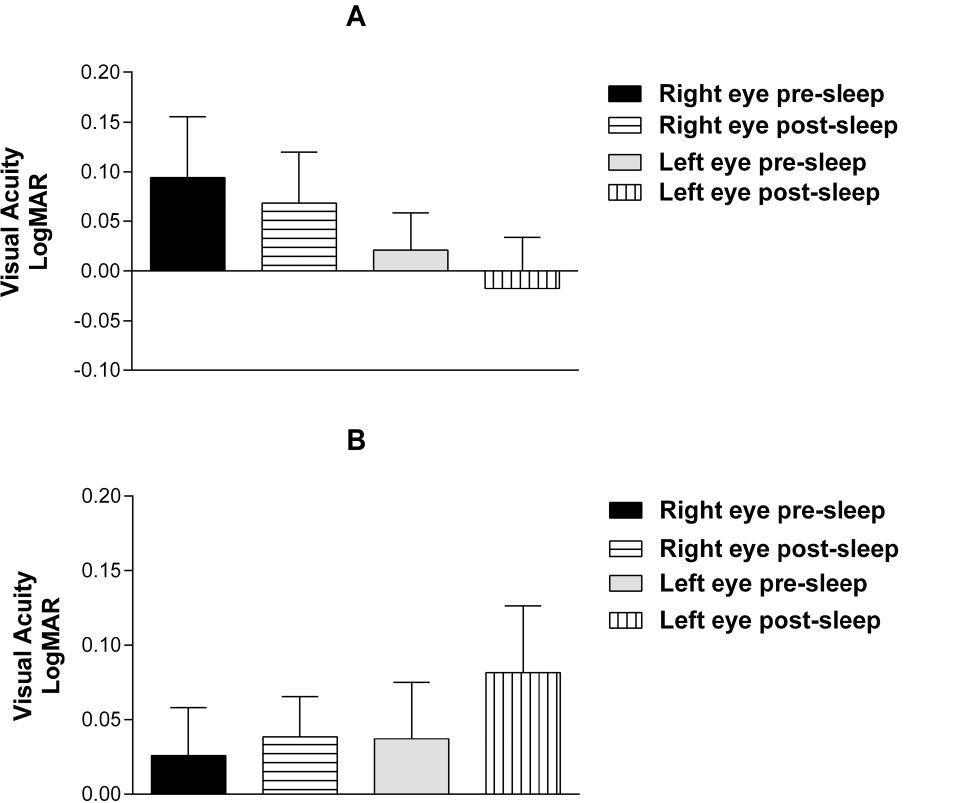
Figure 1. Results of eye chart visual acuity test for the without-CPAP group (A) and with-CPAP group (B) are presented in bar graph. There is no significant difference between groups. Error bars = S.E.M.